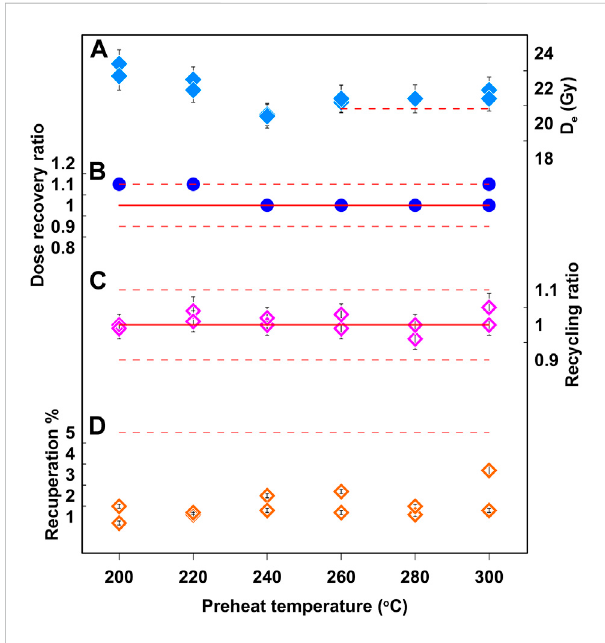
FIGURE 2 Quartz luminescence characteristics for sample SY3-2-G01.